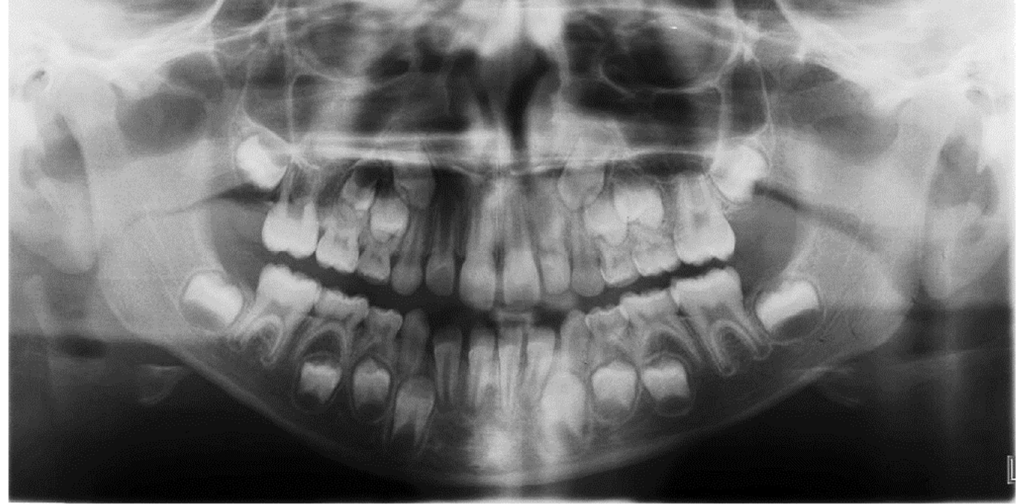
Figure 2. Pretreatment panoramic radiograph. A Class III maxillo-mandibular sagittal relationship emerged from the cephalometric analysis of the pretreatment lateral cephalogram (Figure 3A), while the vertical skeletal relationships appeared normal (Table 1). The cervical vertebral maturation stage was CS1.